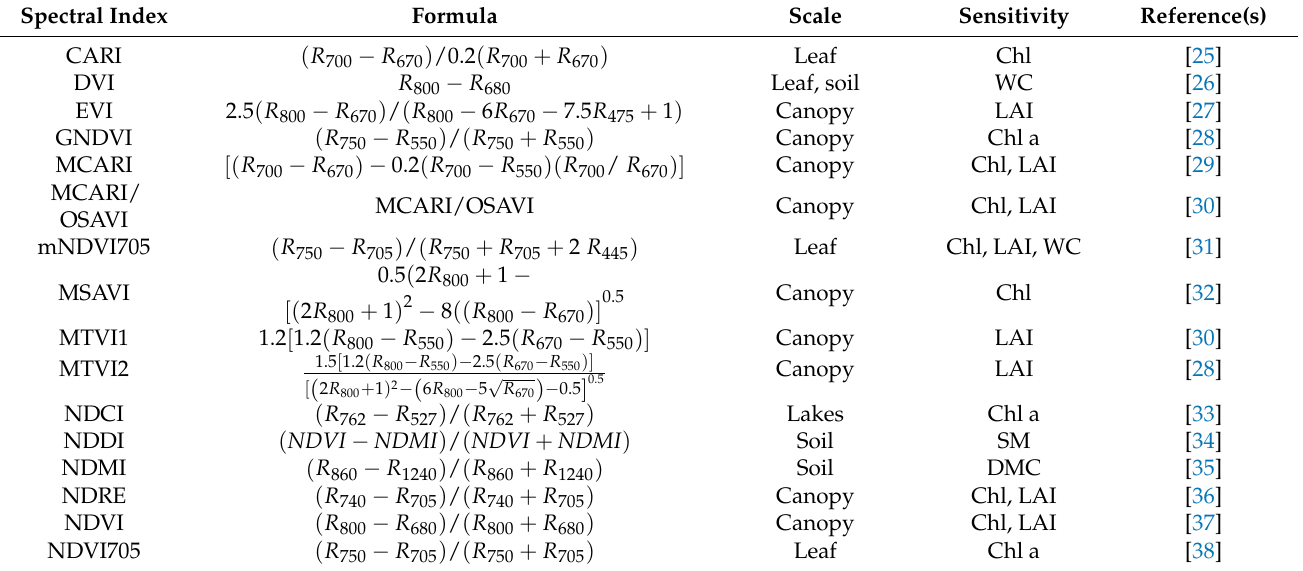
Table 2. Spectral indices considered for the identification of waterlogged areas on agricultural